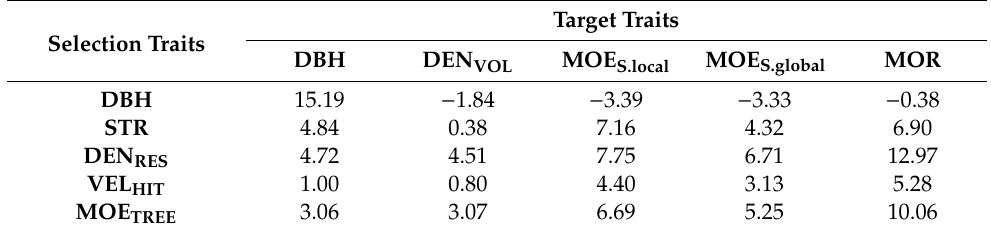
Table 6. Correlated genetic response, expressed as percentages of the mean, of sawn-board traits to selection based on traits non-destructively measured on standing trees (1% selection intensity). Selection